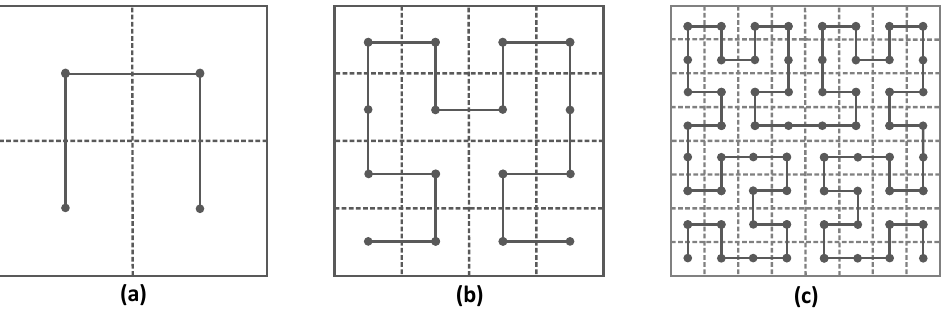
Figure 1. The first three orders of Hilbert space-filling curve: ( a ) 1-order ( k = 1, N = 4); ( b ) 2-order ( k = 2, N = 16); ( c ) 3-order ( k = 3, N = 64).